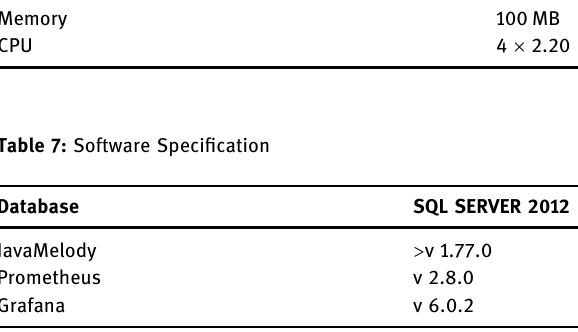
Table 6: Hardware speci fi cation RAM Memory